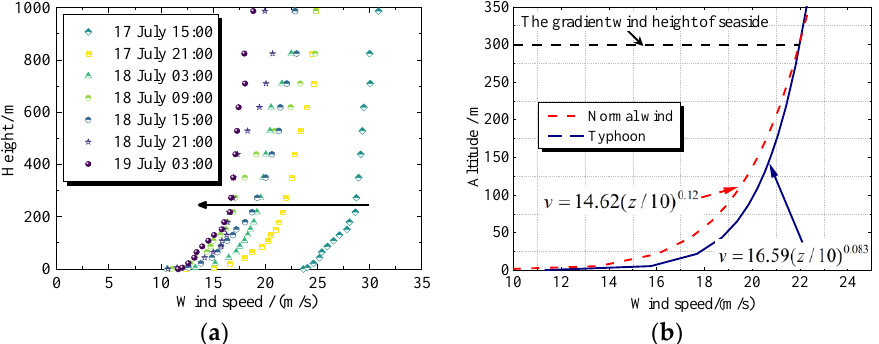
Figure 7. Measured and fitted wind speed profiles of typhoon at different times. ( a ) Measured wind profiles. ( b ) Comparison of fitted wind profiles.